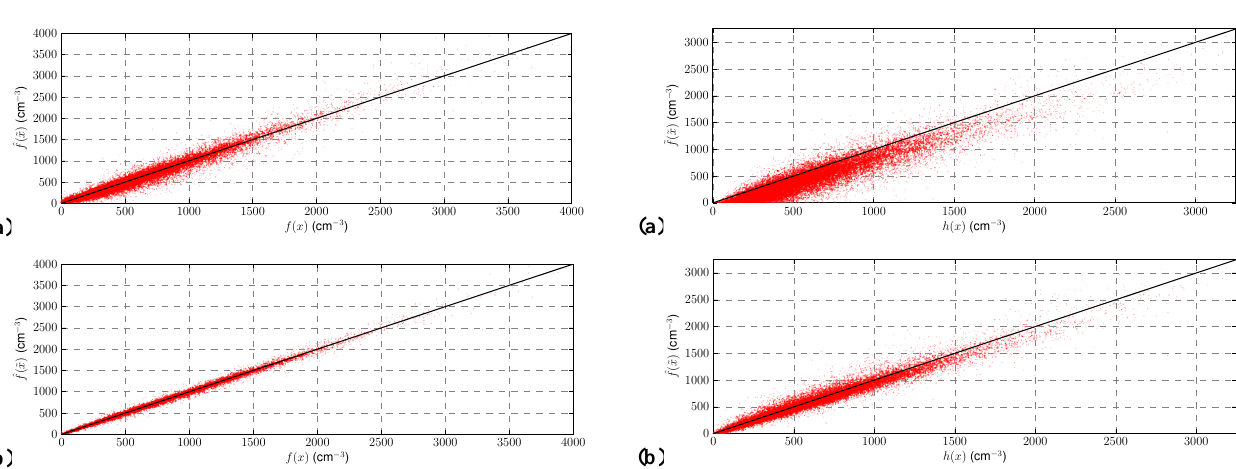
Fig. 7. Cloud droplet number concentrations (CDNC) computed with the approximation error corrected parameterization ˆ f ( ˜ x j ) as functions of CDNCs given by the accurate parameterization f ( x j ) . (a) Reduced parameterization ˜ f ( ˜ x ) with 4 size sections for the rep- resentation of the aerosol particle size distributions. (b) Reduced parameterization ˜ f ( ˜ x ) with 7 size sections for the representation of the aerosol particle size distributions. Black solid lines represent the identity lines.